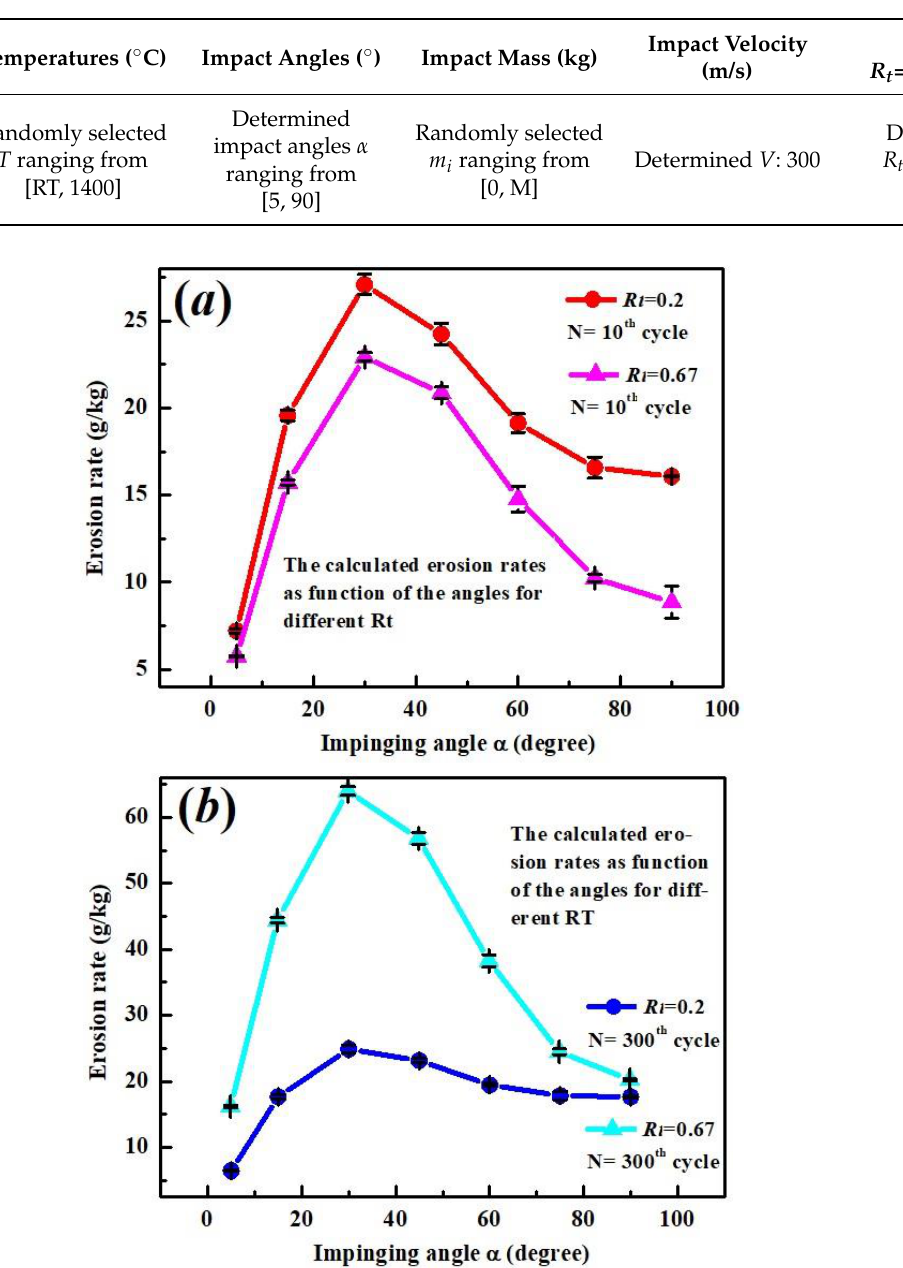
Figure 19. The calculated erosion rate versus impact angles with various ratios R t at selected stages of thermal cycles; ( a ) N = 10; ( b ) N = 300.